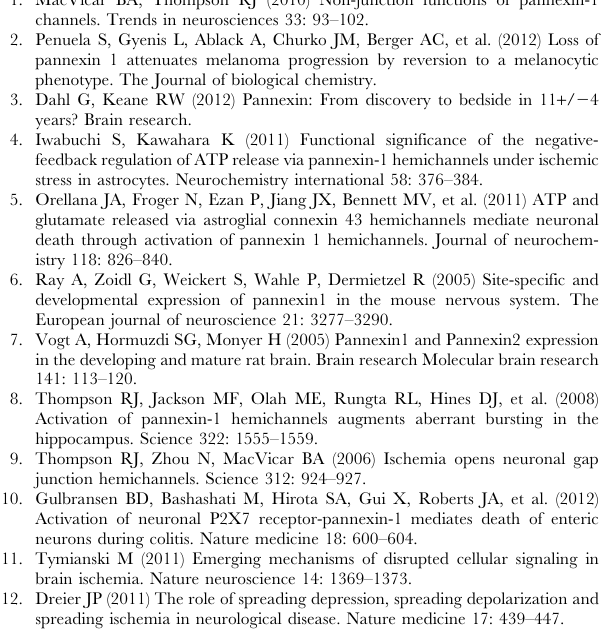
Figure S3 Calbindin and Parvalbumin immunohistochemistry of hippocampus in Panx1 + / + and Panx1 2 / 2 mice. (A, B) Frontal overview vibratome sections, 50 m m thick, show the characteristic calbindin staining pattern of the hippocampal subregions CA1, stratum lucidum (SLU) of CA3 with the positive mossy fibers and the strongly stained dentate gyrus (DG) in Panx1 + / + (left panels) and Panx1 2 / 2 mice (right panels). Enlargements of the CA1 area exhibit no difference in staining of the pyramidal cell layer (PY), stratum oriens (OR) and stratum radiatum (RAD) between both genotypes. Overview micrograph of Parvalbumin immunostaining displays similar staining of Panx1 + / + (E) and Panx1 2 / 2 mice (F). Enlargements of CA1 (G, H) show immunpositive somata of interneurons in the pyramidal cell layer and stratum oriens with the dendrites spanning all layers. Bar in A, B, E, F= 200 m m; bar in B, D, G, H= 100 m m. Figure S4 Expression of selected glutamate receptor family genes. Real Time PCR was performed to analyze relative expression changes of grm1 (mGlu family I), grm2 (mGlu family II), grm4 (mGlu family III), grin1 (AMPA receptor family) and gria1 (NMDA receptor family). HSP90 and 18 sRNA expression was used for normalization. Table S1 Summary of the mean 6 SEM values for Panx1 + / + and Panx1 2 / 2 derived early phase LTP and late phase LTP. Data are listed according to the bath applied pharmacological treatment. Note, that wash in of pharmacology was performed at least 10 min in advance to measurements and was kept upright during the whole phase of LTP recordings. P-Values reveal significances for Holm-Sidack post hoc comparisons, which were